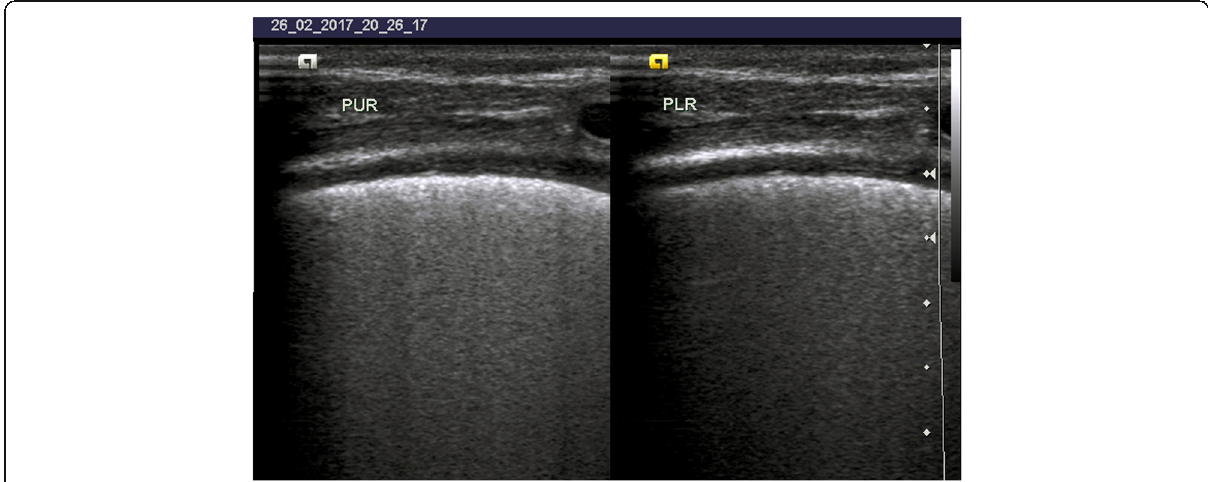
Fig. 2 B-mode ultrasound of the same patient on the day of admission to the NICU. Scanning of the posterior upper and lower zones of the right lung showed of a total loss of A-lines with coalescent B-lines causing curtain appearance giving a local score of 2. The total lung ultrasound score of the patient was